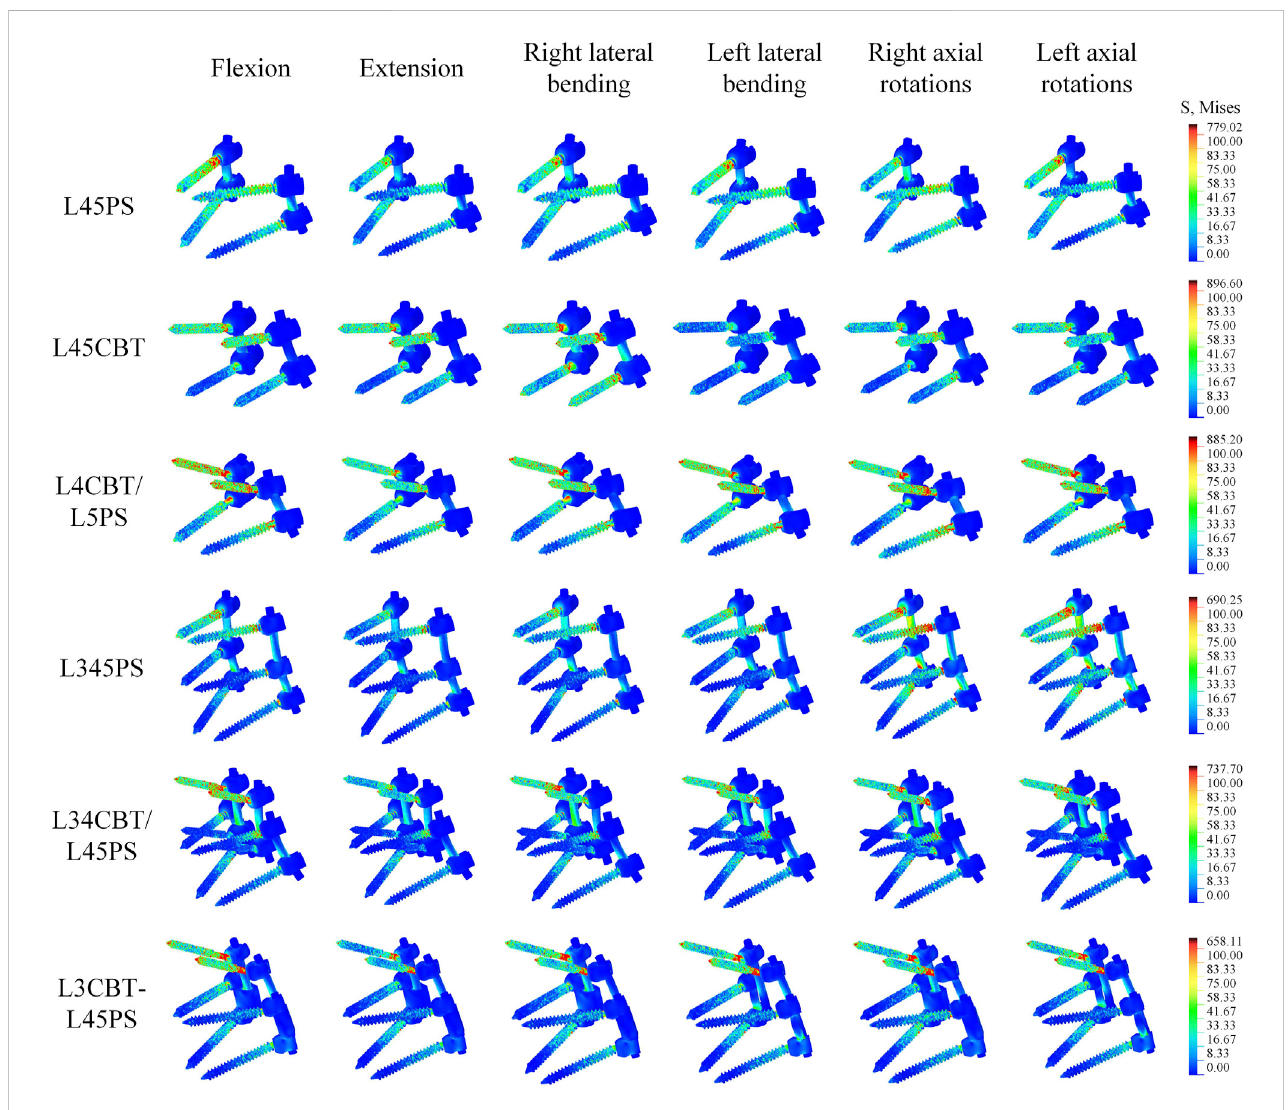
FIGURE 9 The stress distribution of screw – rod systems in six postoperative FEMs under different conditions. According to the indicator diagram, red indicates the stress concentration area, while blue shows the stress dispersion area.